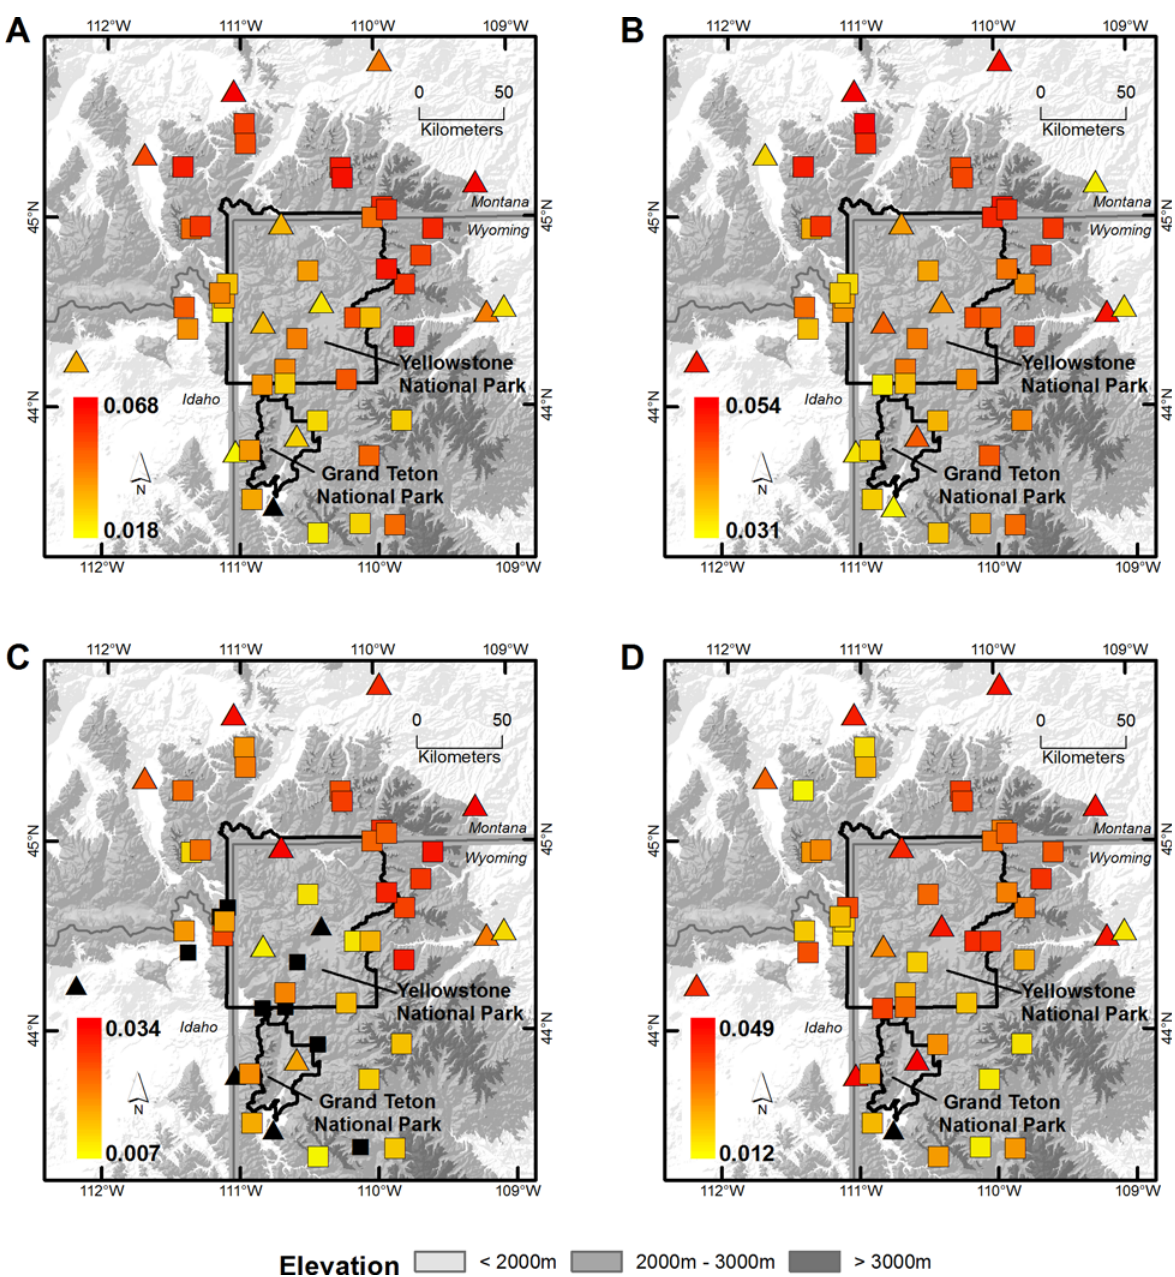
Fig 1. Location of weather station sites and annual trends in minimum and maximum temperatures for winter and summer. Annual trends in the mean minimum (A, C) and maximum (B, D) temperatures for the winter (A, B) and summer (C, D) at SNOTEL ( □ ) and COOP weather station sites ( Δ ) in the Greater Yellowstone Area using the modeled SNOTEL + COOP data, 1948 – 2012. All sites had positive trends and trend magnitude is indicated in the legend with warmer colors.